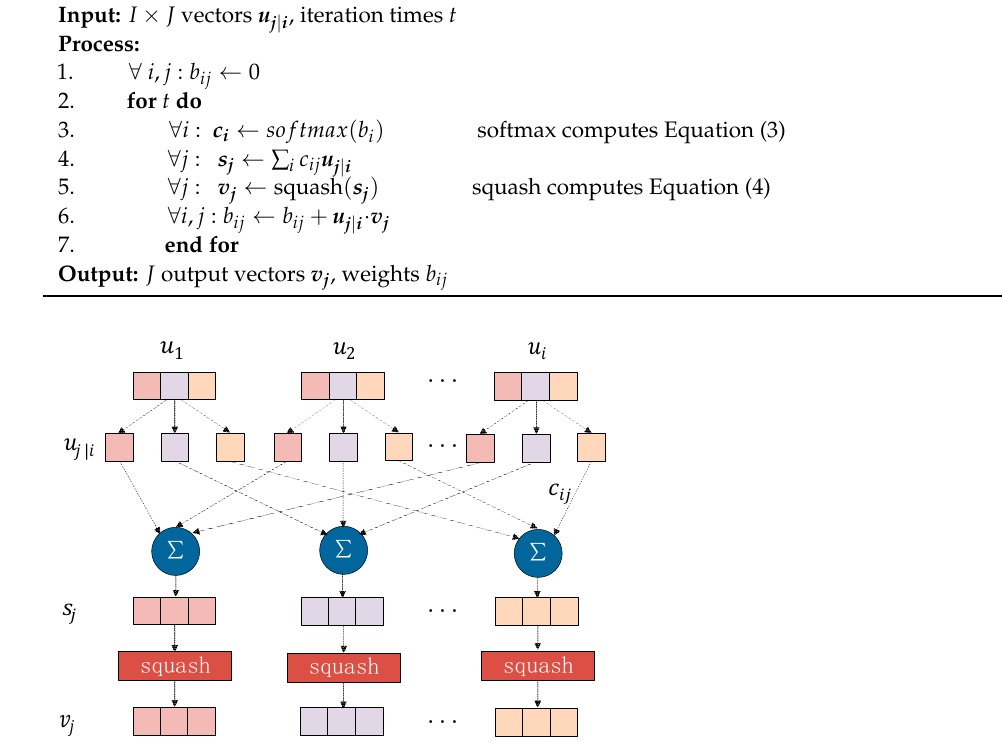
Figure 3. The architecture of the capsule network. Algorithm 1 Dynamic Routing